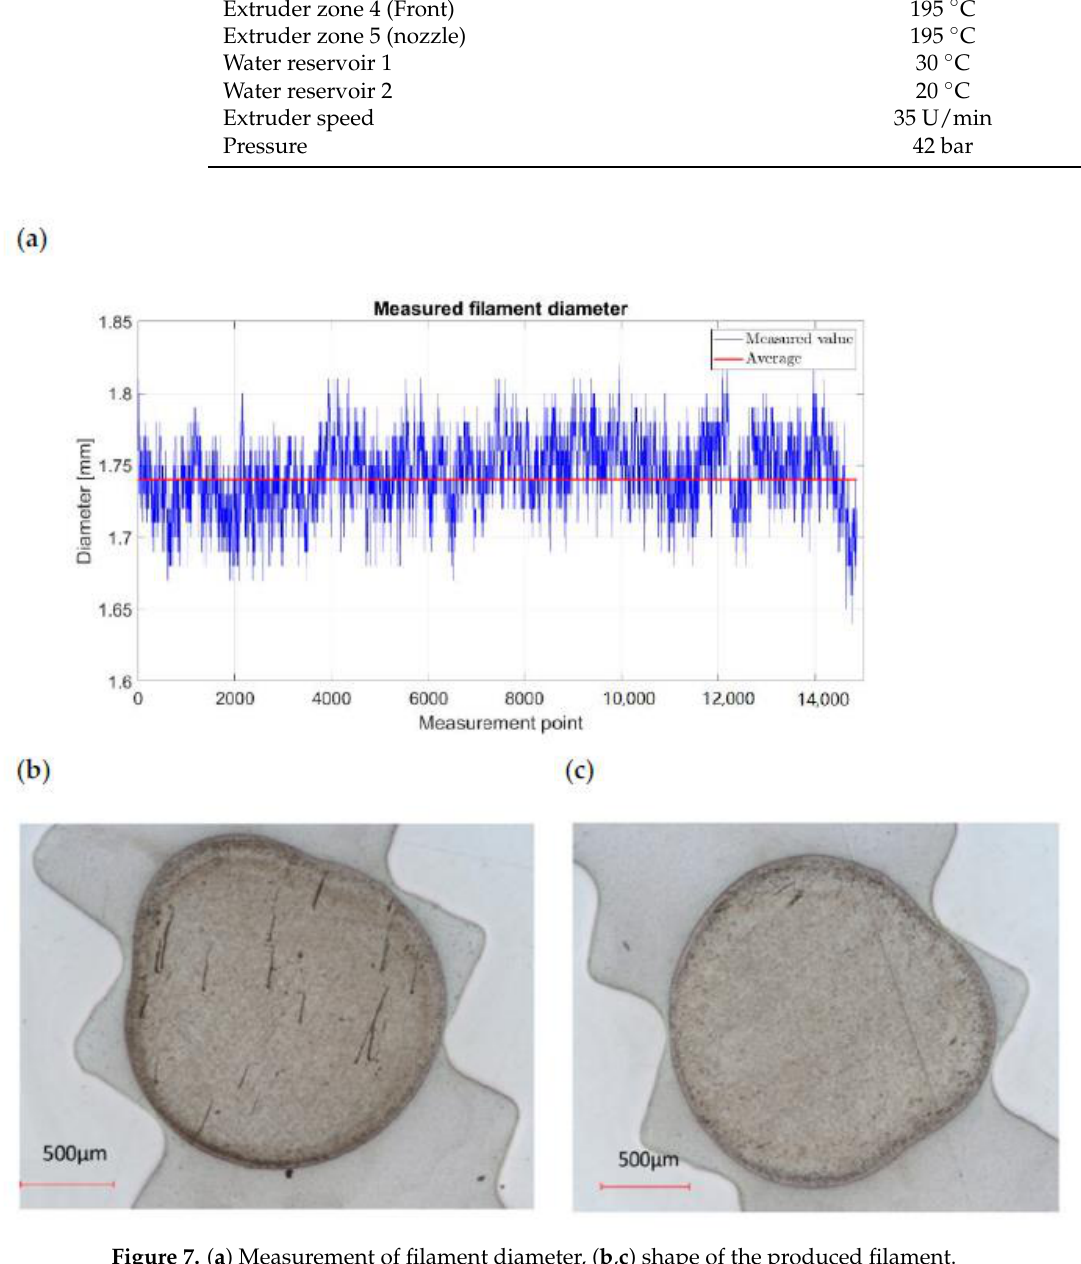
Figure 7. ( a ) Measurement of filament diameter, ( b , c ) shape of the produced